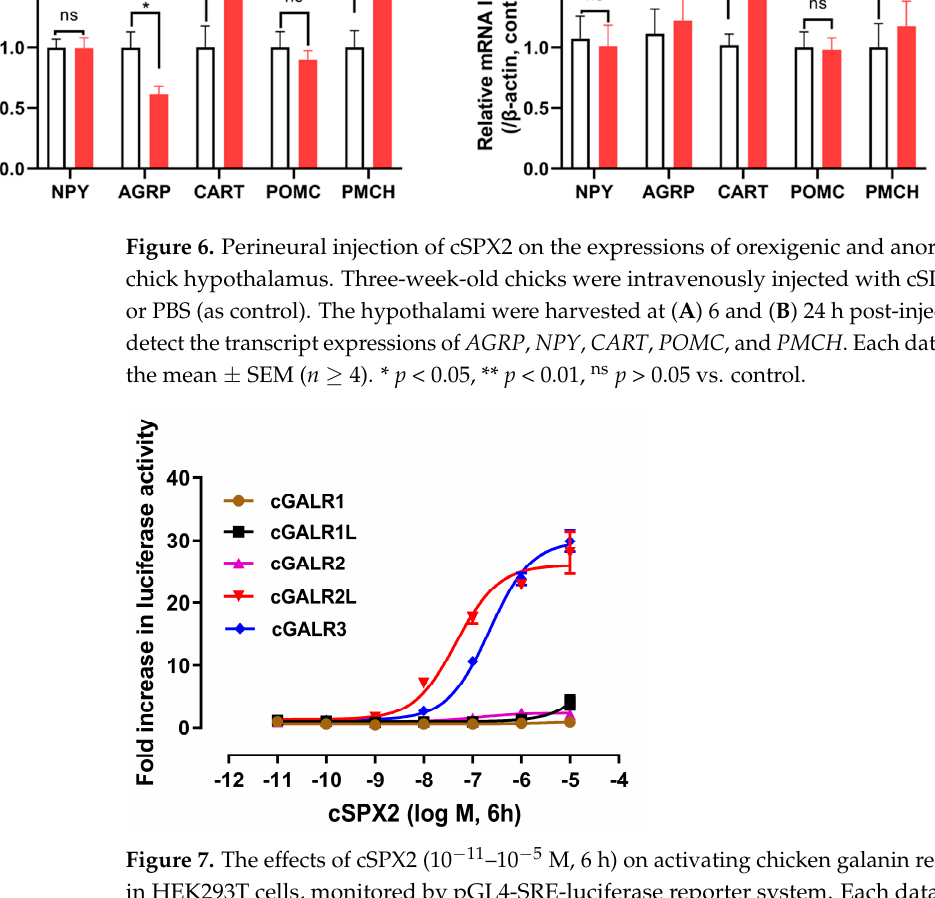
Figure 6. Perineural injection of cSPX2 on the expressions of orexigenic and anorexigenic genes in chick hypothalamus. Three-week-old chicks were intravenously injected with cSPX2 (50 ng/g BW) or PBS (as control). The hypothalami were harvested at ( A ) 6 and ( B ) 24 h post-injection, and used to detect the transcript expressions of AGRP , NPY , CART , POM C, and PMCH . Each data point rep- resents the mean ± SEM ( n ≥ 4). * p < 0.05, ** p < 0.01, ns p > 0.05 vs. control.